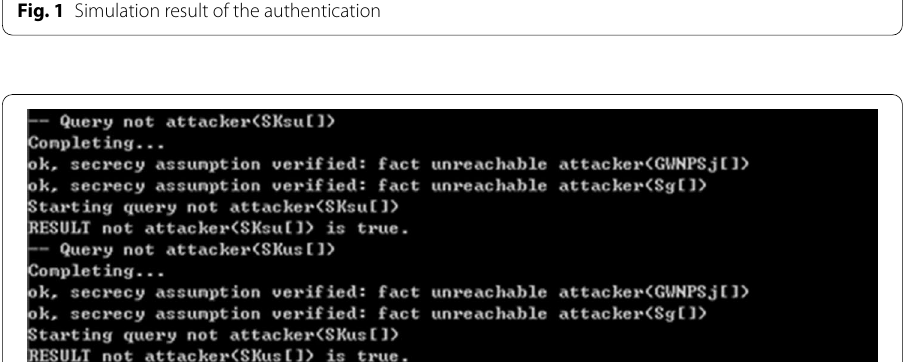
Fig. 1 Simulation result of the authentication